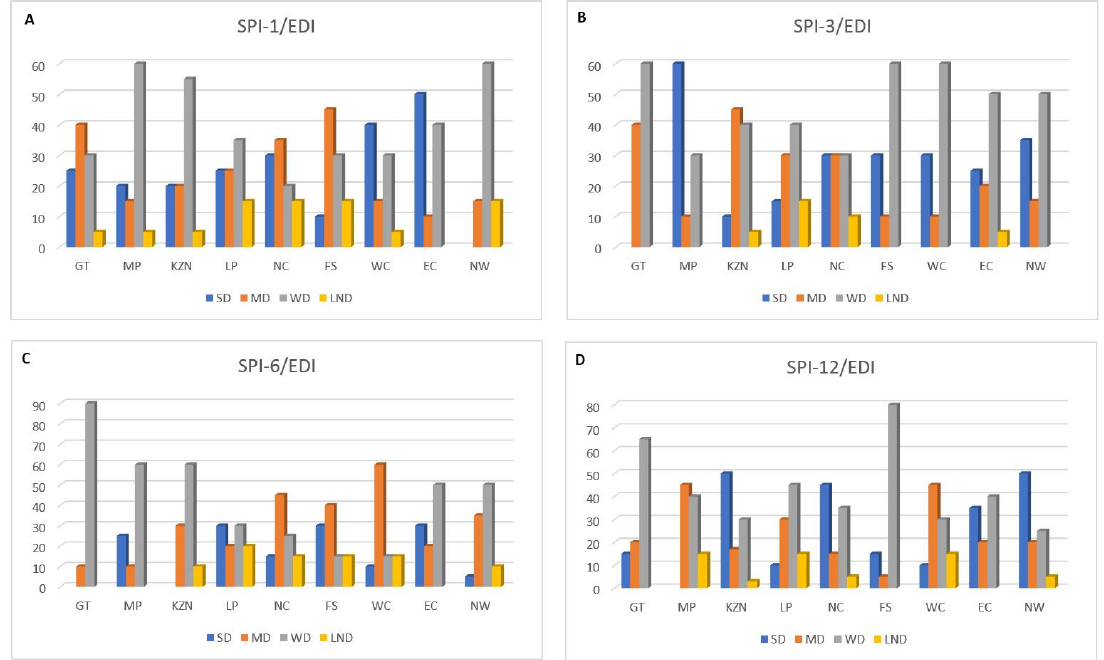
Figure 8. Percentage of the periodogram dissimilarity measure for drought duration in South Africa. ( A ) SPI-1/EDI; ( B ) SPI-3/EDI; ( C ) SPI-6/EDI; and ( D ) SPI-12/EDI. Strong Dissimilarity (SD), Moderate Dissimilarity (MD), Weak Dissimilarity (WD), Little or No Dissimilarity (LND).